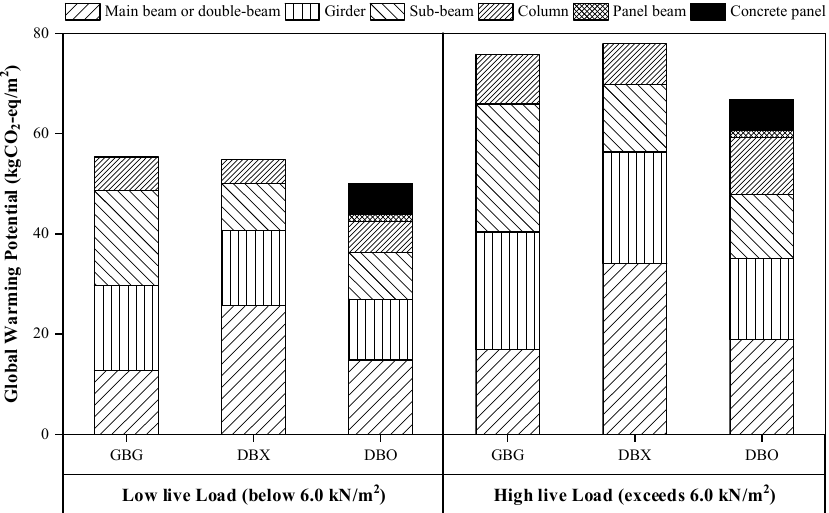
Figure 11. Comparison of global warming potentials (GWPs) occupied by the structural members in the different structural systems according to the level of live load.